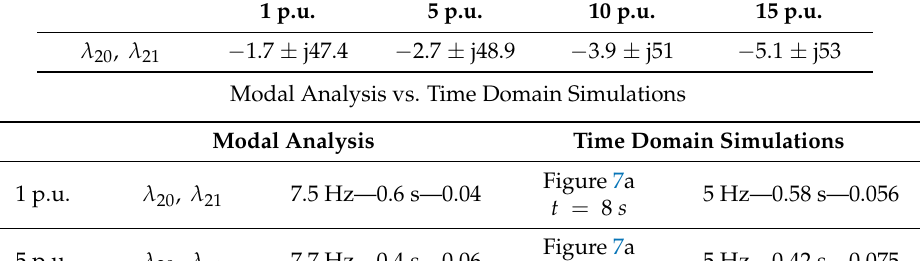
9 of 19 Figure 5. The dc-link voltage response of the VSC2 following a step variation in (cid:1848) (cid:3031)(cid:3030)(cid:2869)∗ and (cid:1848) (cid:3031)(cid:3030)(cid:2870)∗ from 1 to 1.05 p.u. at (cid:1872) = 4s. ( a ) (cid:1837)